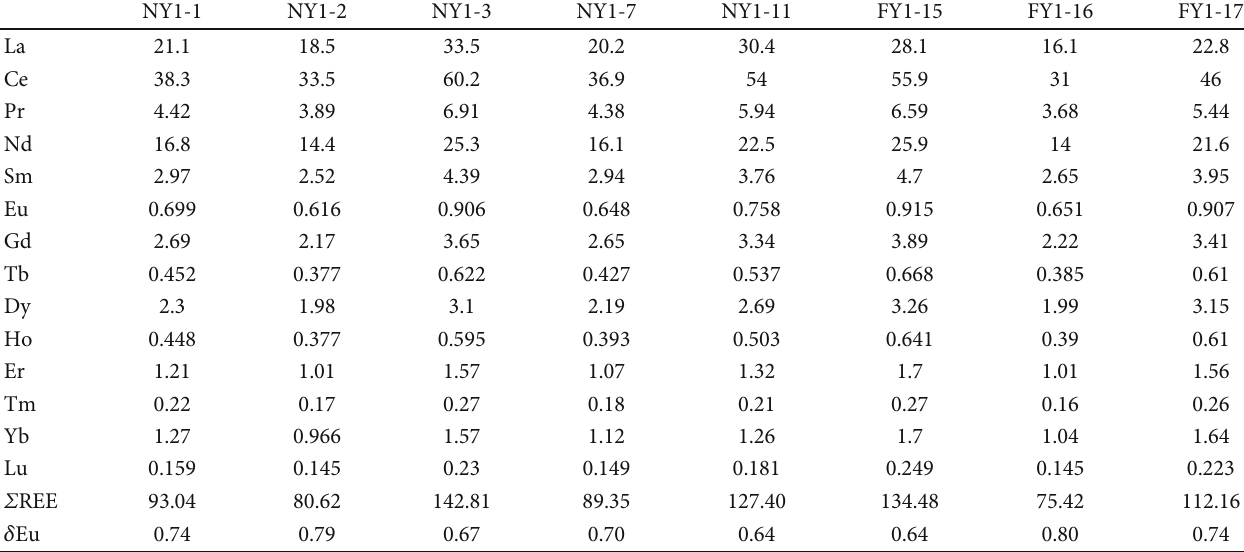
Table 7: The REEs results in micritic lamina ( μ